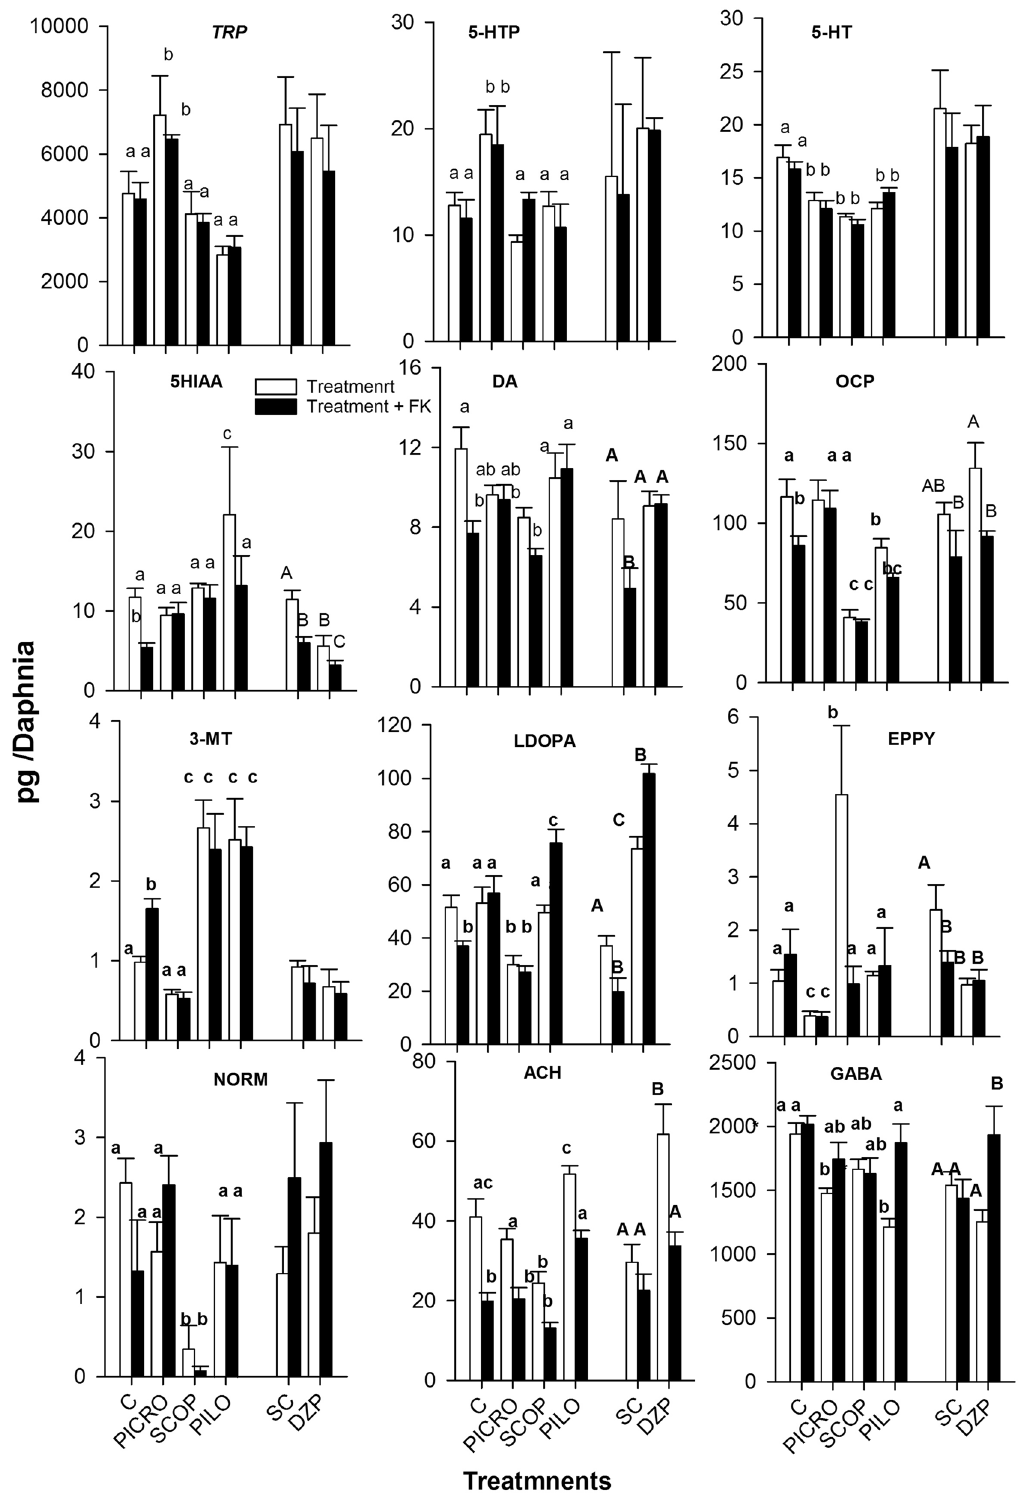
Figure 3. Up to 12 out of the 17 analysed neurotransmitters and related metabolites responded to the studied treatments. Selected neurotransmitters and their related metabolite concentrations (mean ± SE, N = 5–10) in the whole-body tissues of D. magna females exposed to the studied chemical treatments. The results are from two different experiments. Experiment 1 included the control (C), PICRO, SCOP, and PILO, and experiment 2 included a solvent control (SC) and DZP treatments; the results are depicted together. Within each graph, different letters indicate significant ( P < 0.05) differences following ANOVA and multiple Tukey’s multiple comparisons tests. To avoid confusion, letters differentiating the DZP experiment are in upper case. The lack of any letter indicates non-significant ( P ≥ 0.05)